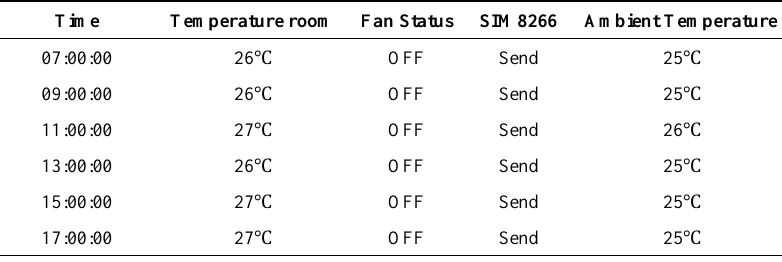
Table 4. Testing of room temperature control in rainy weather.